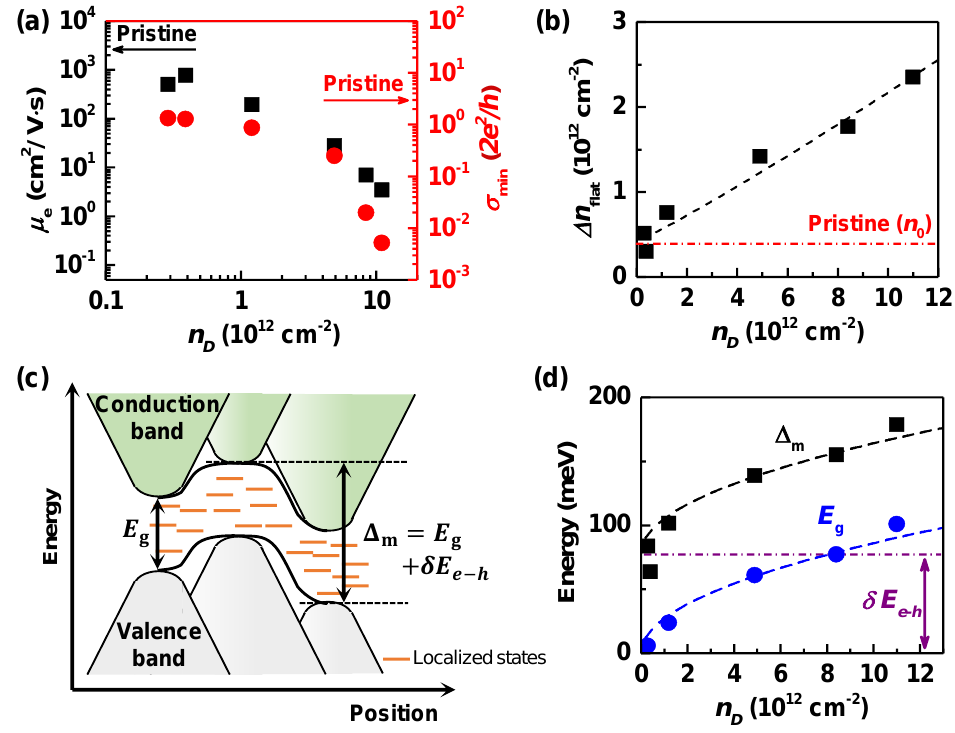
Figure 3. ( a ) Electron side mobility µ e (black square) and conductivity minimum σ min (red circle) of graphene oxide as a function of n D . Arrows indicate the values of µ e and σ min for pristine graphene. ( b ) ∆ n flat versus n D . The black dashed line is a linear fit to the data. Note y-intercept n 0 , associated with the electron–hole puddle in pristine graphene. ( c ) Schematic band diagram of graphene oxide and the illustration of an electron-hole puddle, affecting the transport gap observed. ( d ) Transport gap (black square) and inferred bandgap (blue circle) of graphene oxide as a function of n D . Dashed √ n D and the dot-dash line indicates the size of potential fluctuation due lines are fitting curves with to e − h